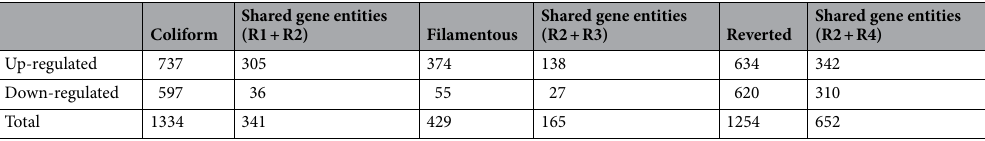
Table 1. Differentially expressed gene entities with a ≥ 2 fold change.